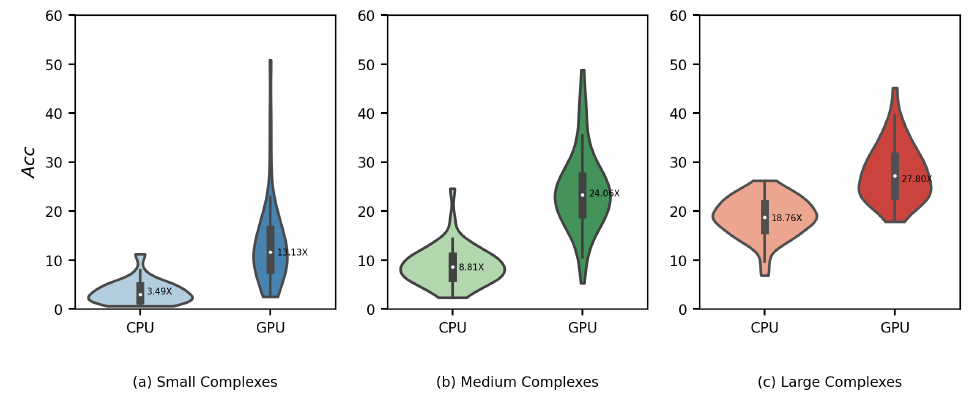
Figure 12. Acceleration of docking time ( Acc ) of the Vina-GPU implementations on CPUs (indicated by “CPU”) against on GPUs (indicated by “GPU”). All 140 complexes are classified into three sub- datasets with different complexity (small—5–23 atoms, medium—24–36 atoms, large—37–108